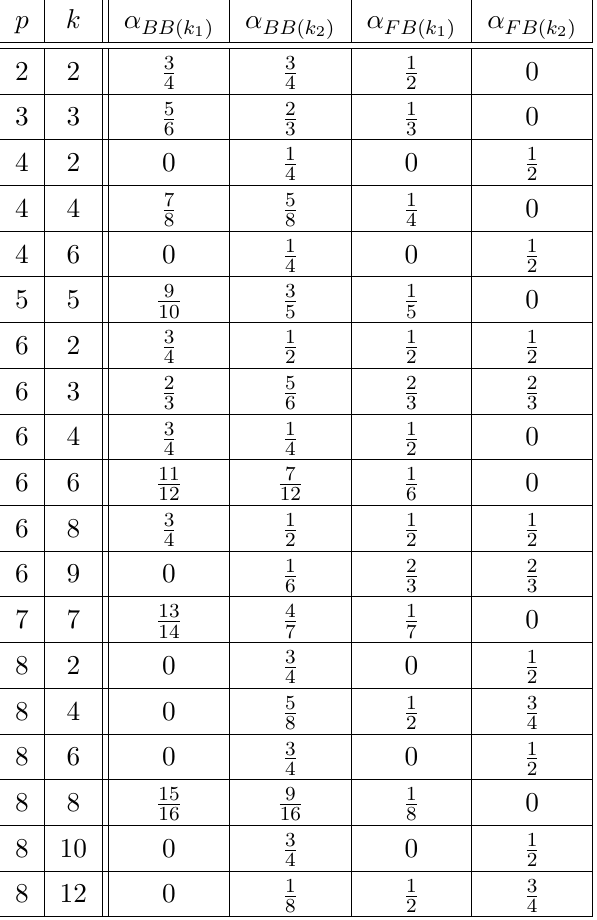
Table 4 . A selection of the Y p,k ( CP 2 ) SymTFT coefficients obtained for selected p, k values with non-trivial gcd ( p, k ) . Note we have also not included pairs of gcd ( p, k ) values related by ( p, k ) → ( p, 3 p − k ) .